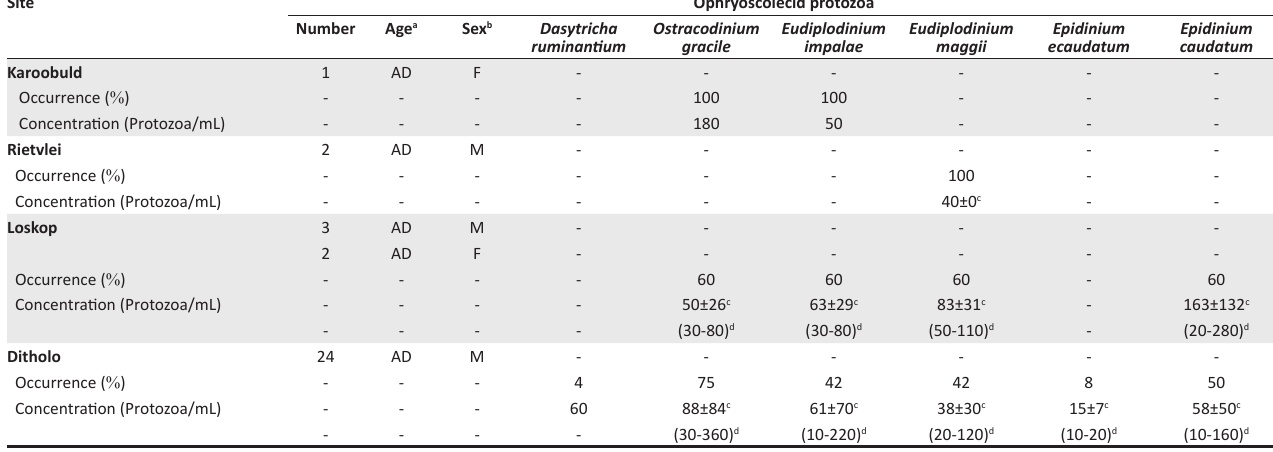
TABLE 3: Occurrence and concentration of Dasytricha ruminantium and larger ophryoscolecid protozoa in the caecum or colon contents of impala. Site